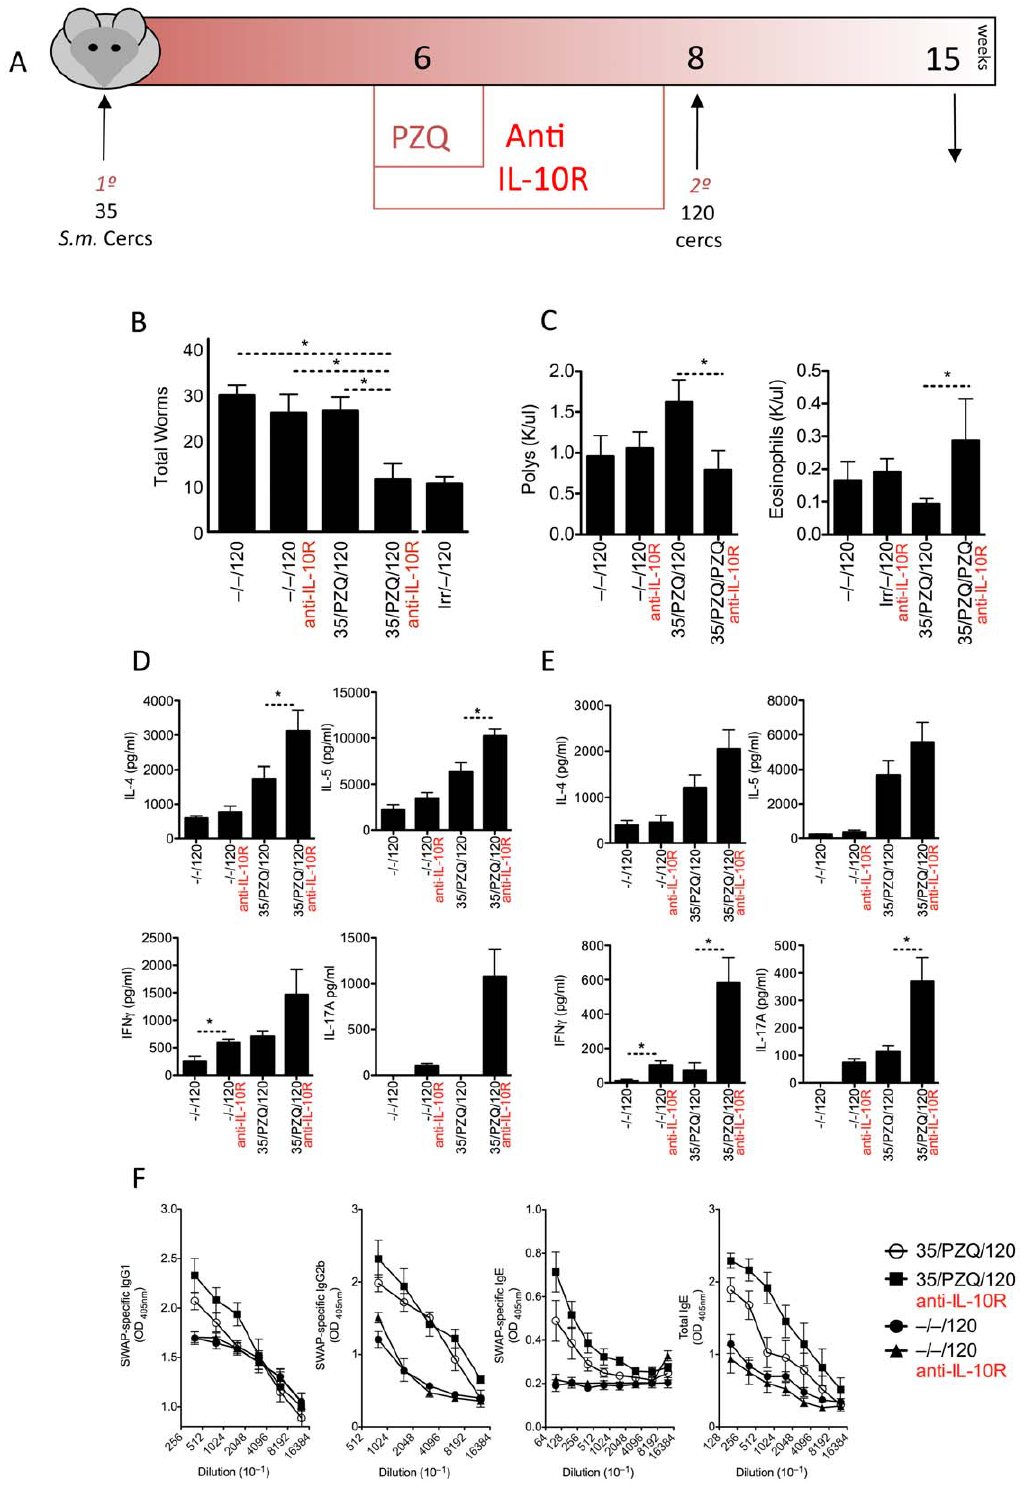
Figure 5. IL-10-blockade establishes resistance to re-infection. C57BL/6 mice were infected as in Figure 2, with a sub group of mice treated with anti-IL-10RAb (1 mg/mouse at the start of PZQ treatment- wk6, wk7 and wk 8). Data shown are mean 6 SEM from one of 3 experiments, with 7 mice per group. (A) Experimental model diagram. (B) Total worm numbers at week 15. (C) Circulating eosinophils and poly-morphonuclear cells. (D) Cytokine secretions, measured by ELISA, from adult worm antigen re-stimulated splenocytes. (E) Cytokine secretions, measured by ELISA, from adult worm antigen re-stimulated mesenteric lymph node cells. (F) Anti-worm antibody responses, measured by ELISA.